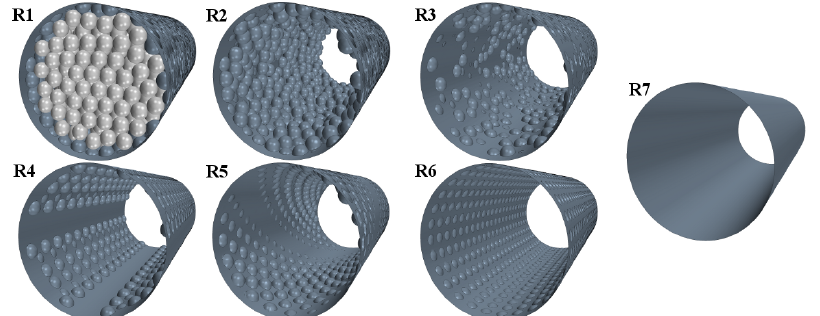
Figure 3. Investigated wall structure overview: R1—ideal; R2 is like R1, but refilled (later referred to as ideal wall reactor (IWR)); R3 is like R2, but spheres belonging to the wall structure are removed if their centroid resides within the tube; R4–R6—different regular arrangements (R5 is later referred to as oscillating wallstructure reactor (OWR)); R7—plain wall (later referred to as plain wall reactor (PWR)).